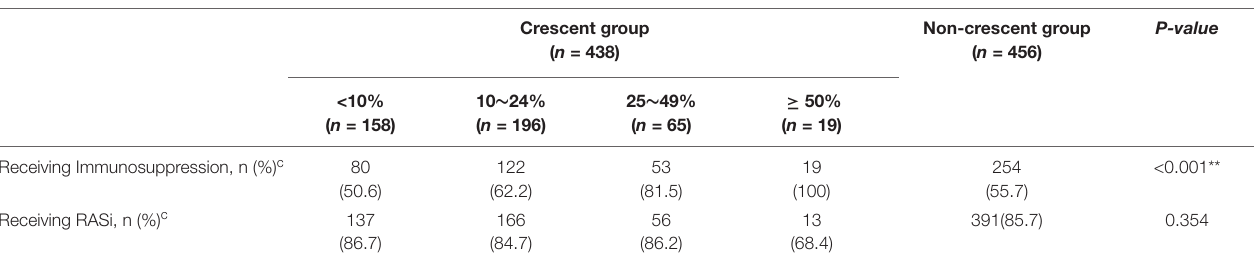
TABLE 3 | During follow-up patients with or without immunosuppression and